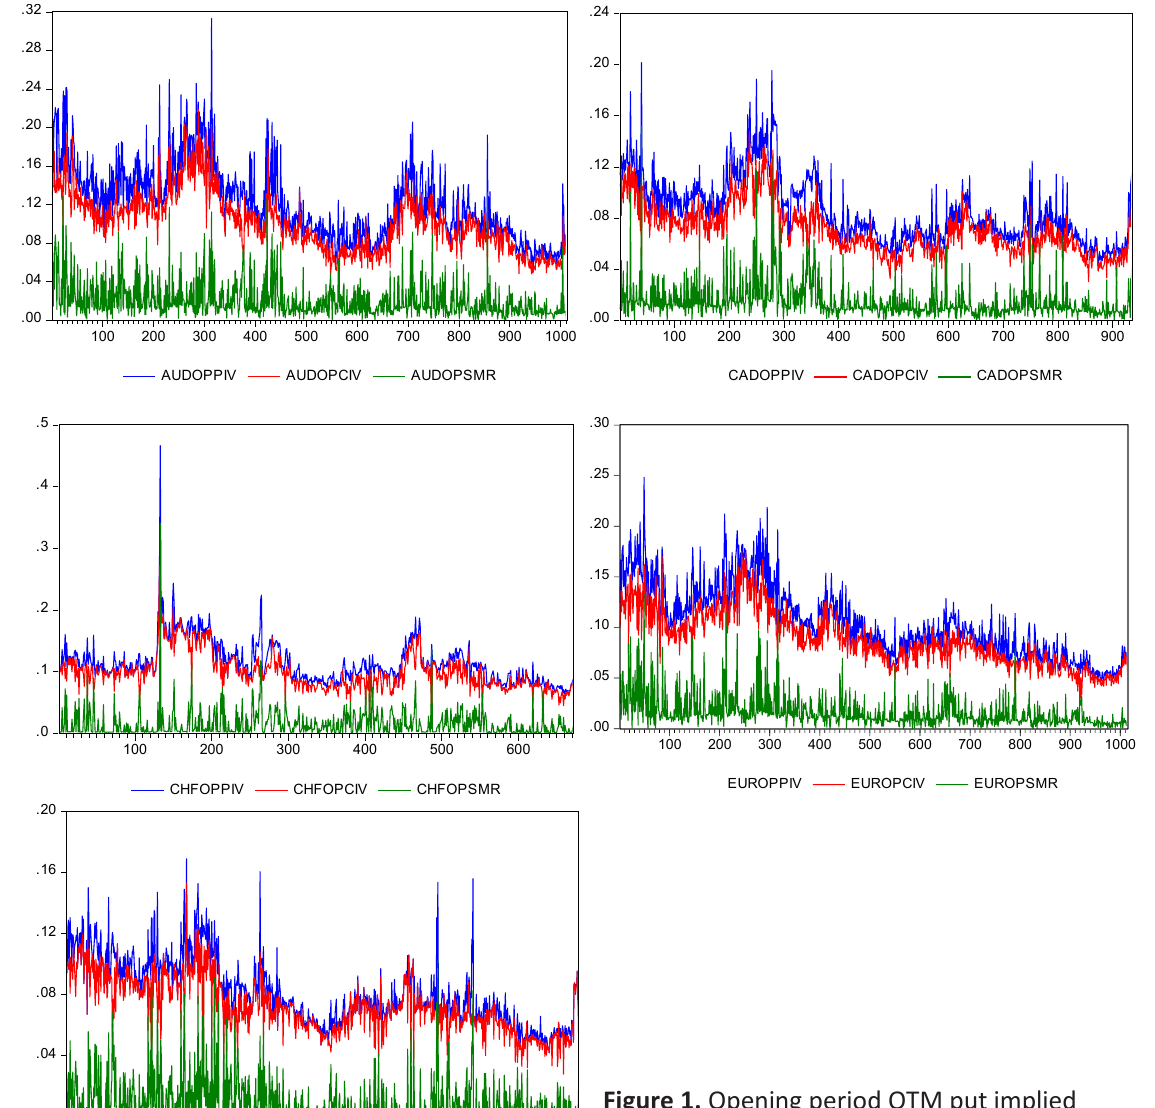
Figure 1. Opening period OTM put implied volatility (blue color), ATM call implied volatility (red color) and volatility smirk (green